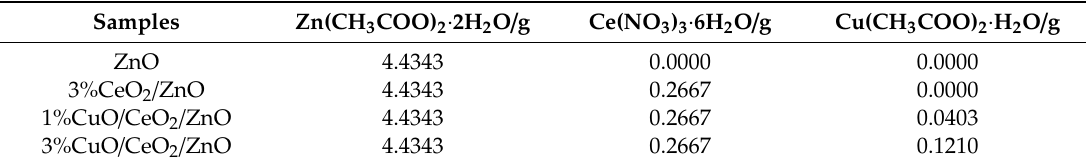
Table 1. Main reagent masses used in synthetic processes of CuO / CeO 2 / ZnO.